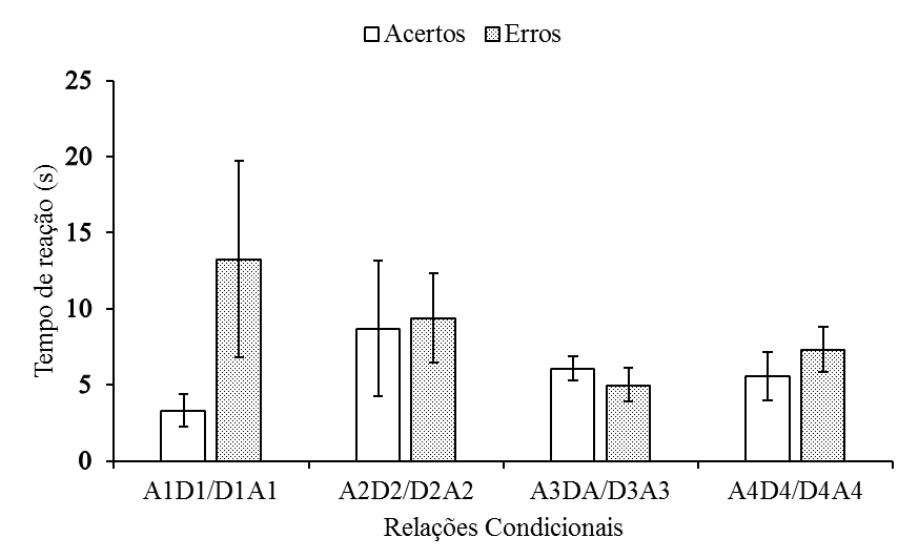
Figura 2 . Tempo de reação médio em segundos nas tentativas com acertos e com erros diante das relações emergentes de transitividade (A1D1, A2D2, A3D3, A4D4) e transitividade simétrica (D1A1, D2A2, D3A3, D4A4) das classes 1, 2, 3 e